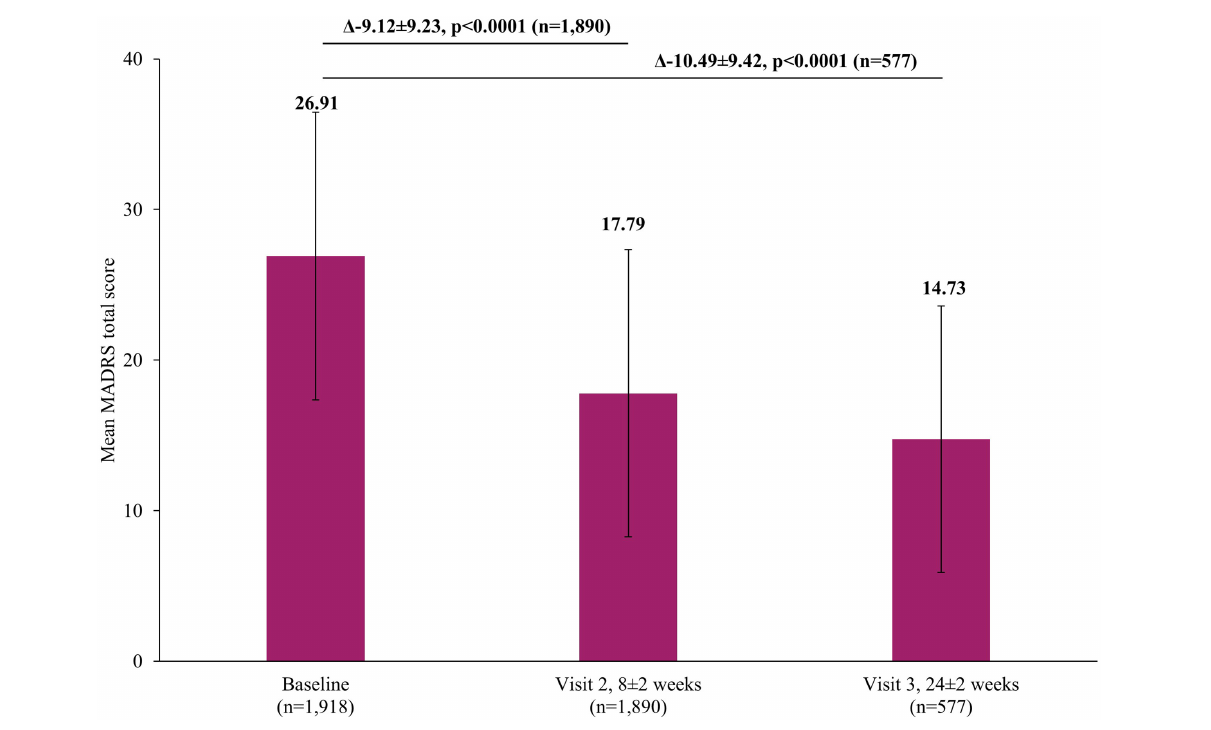
FIGURE3 Change in MADRS total score from baseline. The mean MADRS total score at Visit 1 was based on all patients, not just those that also had data at Visit 2 or Visit 3, however, when analyzing the difference between the visits (Visit 1 to Visit 2 and Visit 1 to Visit 3), scores of patients who had scores at both visits were included. Therefore paired t -tests assessed the difference at Visit 2 (8 ± 2 week) versus Visit 1 (0 week) in 1,890 patients and difference at Visit 3 (24 ± 2 week) versus Visit 1 (0 week) in 577 patients. Error bars represent standard deviations. MADRS, Montgomery-Asberg Depression Rating